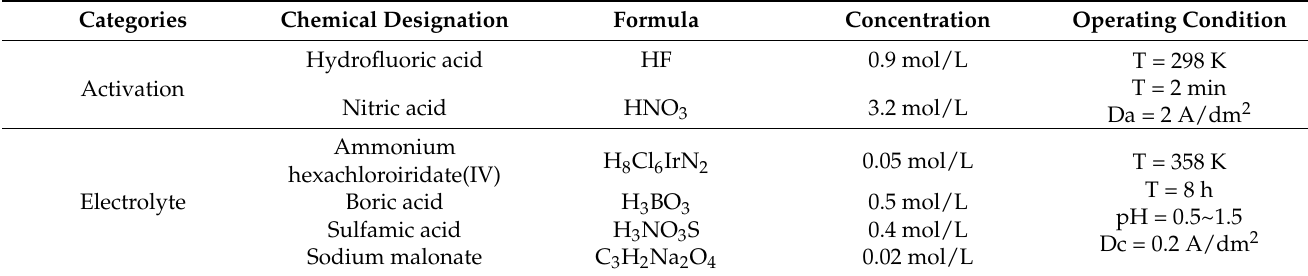
Table 1. The solution components and operating conditions using in electroplating